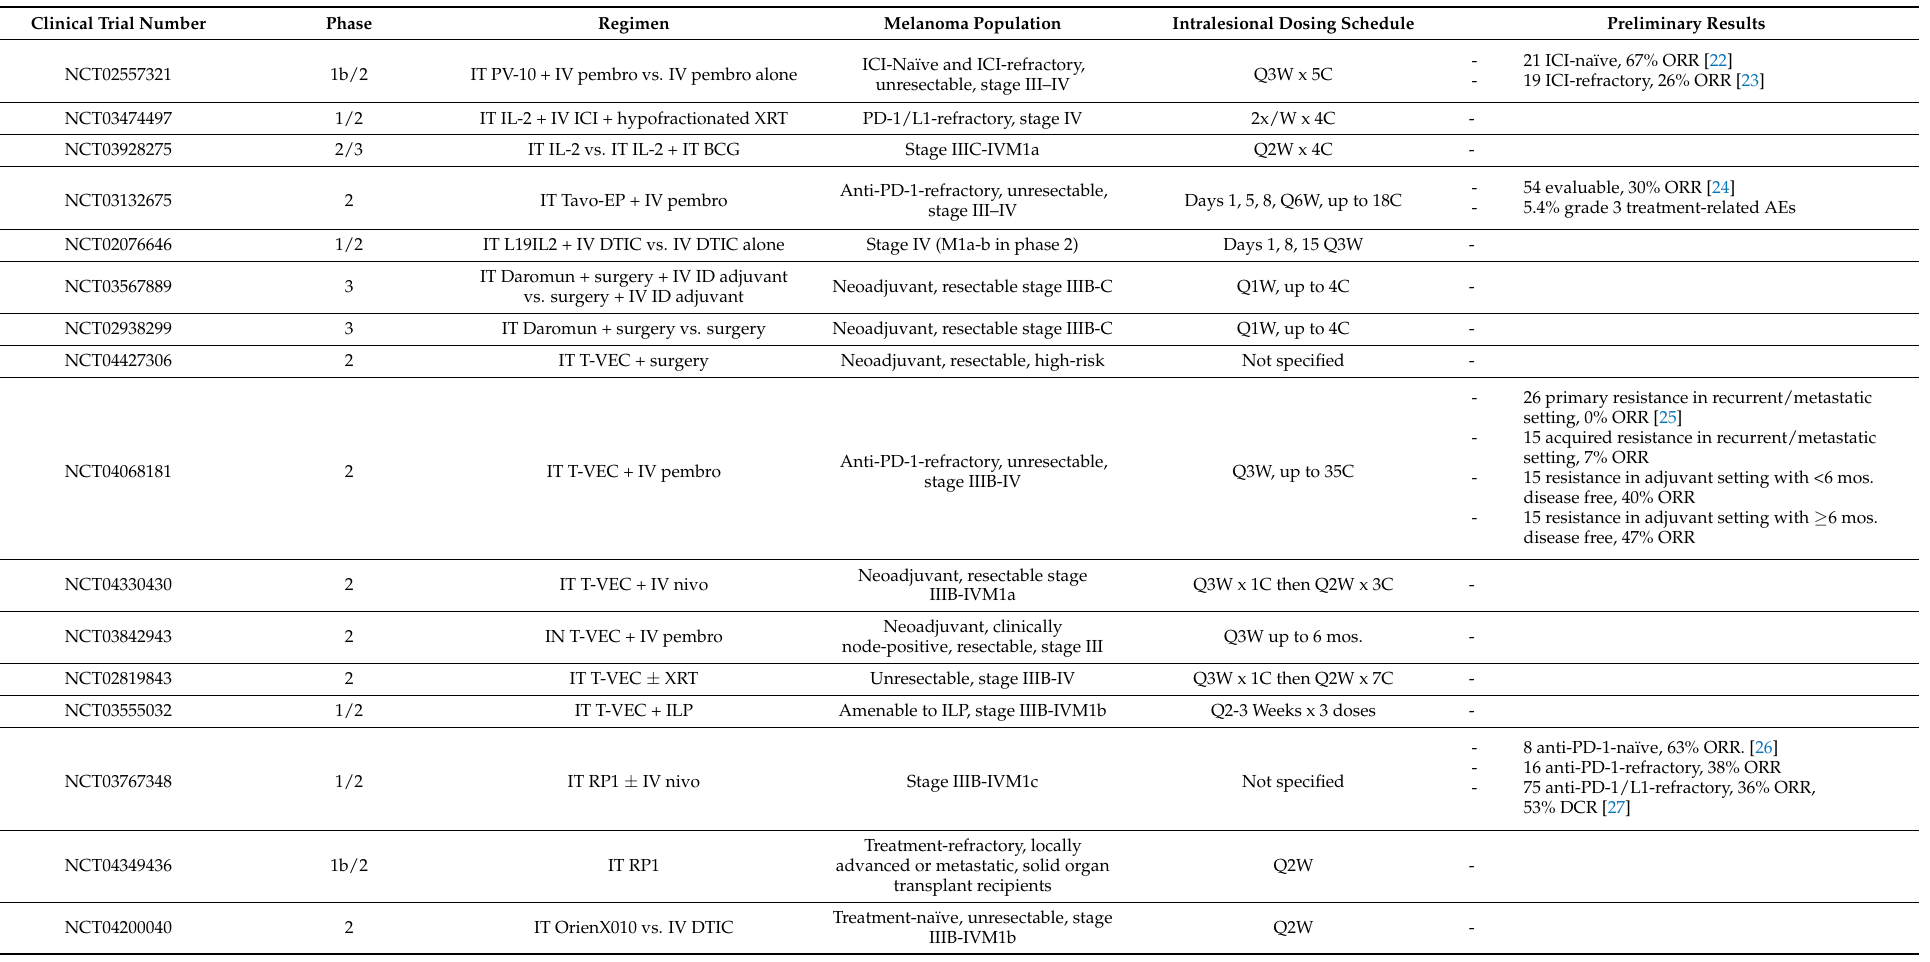
Table 1. Ongoing Phase 2 or Later Clinical Trials of Intralesional Therapy for Locoregionally Advanced and Metastatic